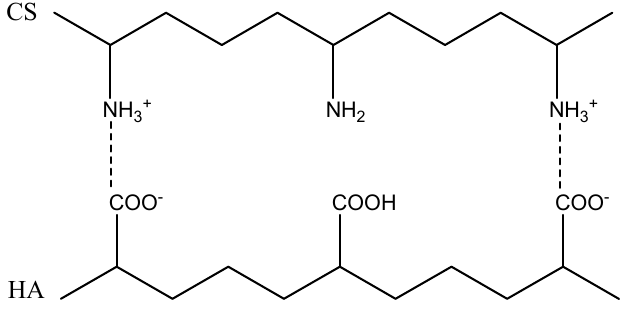
Figure 2. Schematic representation of the polyelectrolyte complexation reaction between chitosan (CS) and hyaluronic acid